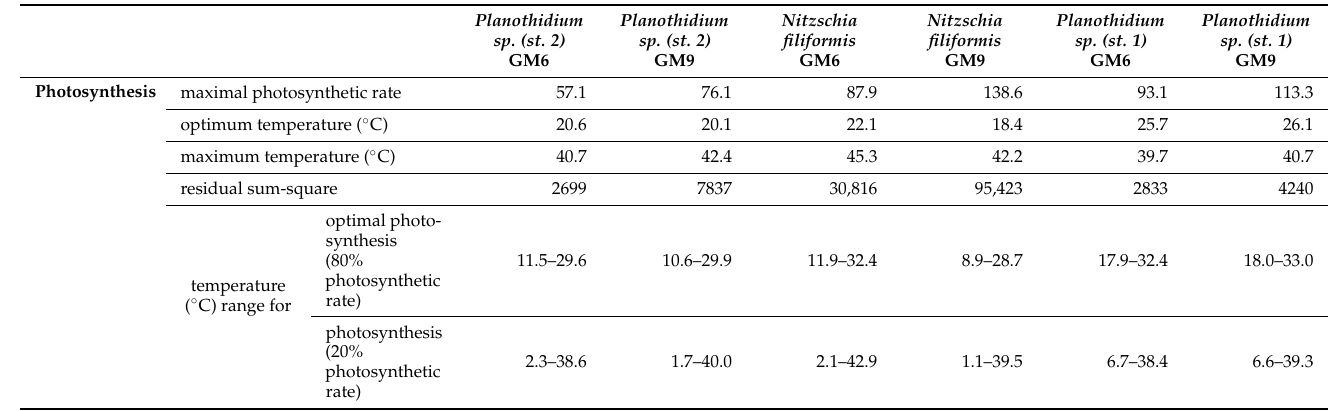
Table 4. Results of model calculation for temperature-dependent photosynthetic and